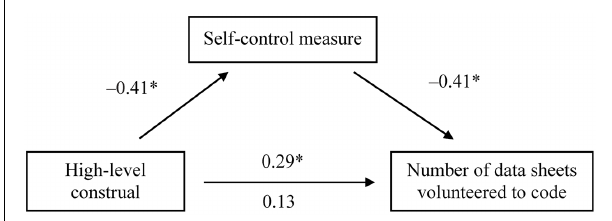
FIGURE 1 | Mediation of the effect of exposure to “why” questions (high-level construal) regarding morality on the number of data sheets participants volunteered to code in Experiment 1. Values are standardized regression coefficients. The self-control measure was indexed as the mean difference in reaction time (ms) between incongruent and congruent trials in the Stroop task. Less Stroop interference indicates a state of greater self-control. On the lower path, the values below and above the arrow are the results of analyses in which the mediator was and was not included in the model, respectively. Asterisks indicate significant results ( p <